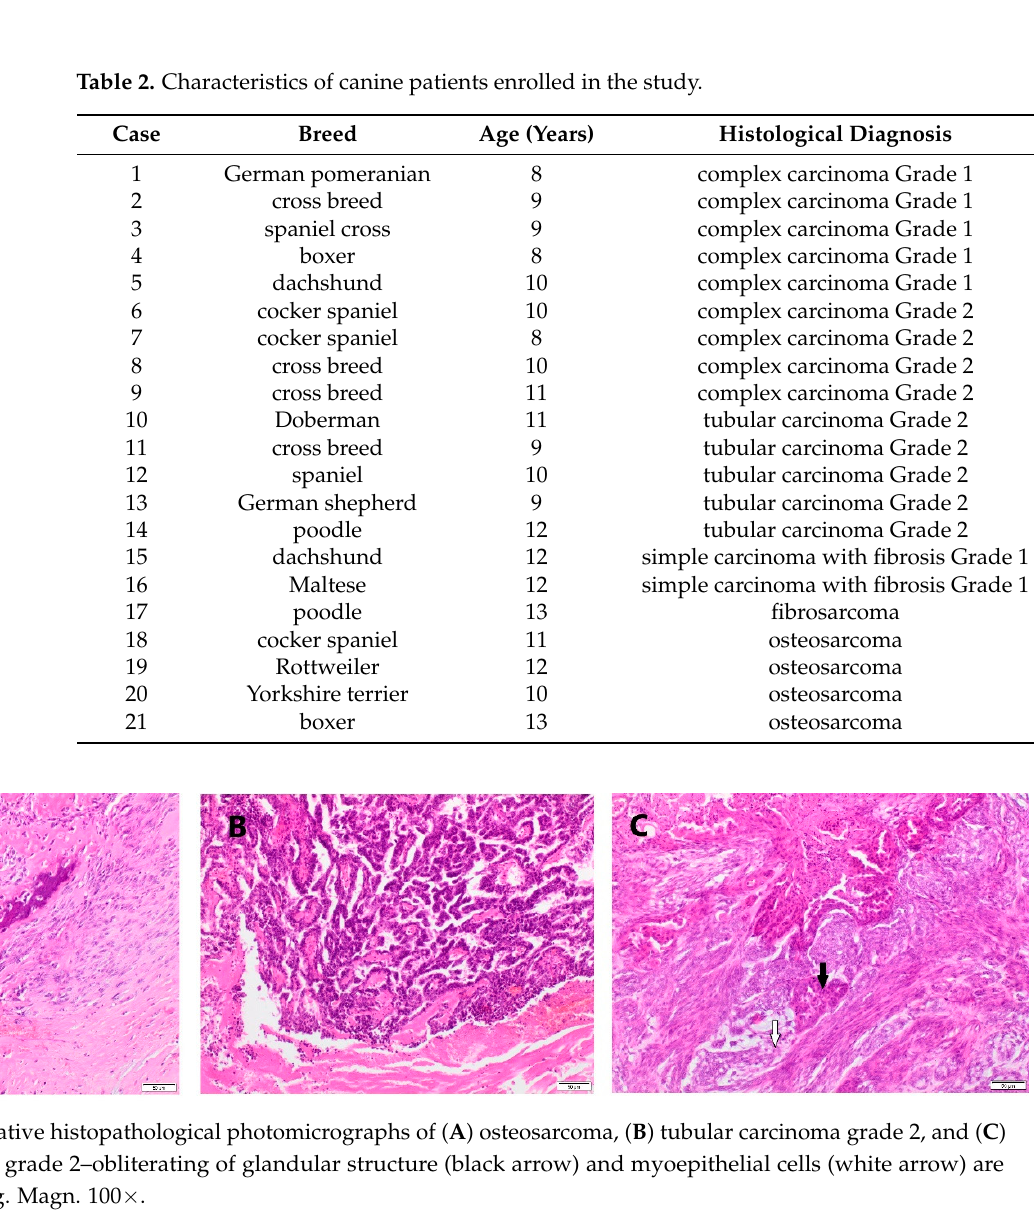
Table 2. Characteristics of canine patients enrolled in the study.